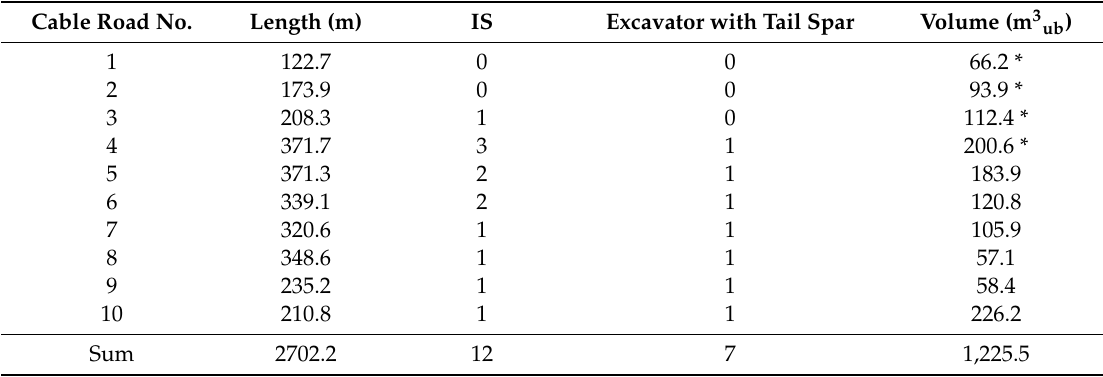
Table 1. Number and length of cable roads, amount of intermediate supports (IS), use of excavator with tail spar function, and amount of harvested biomass in the applied cable-based system. Cable Road